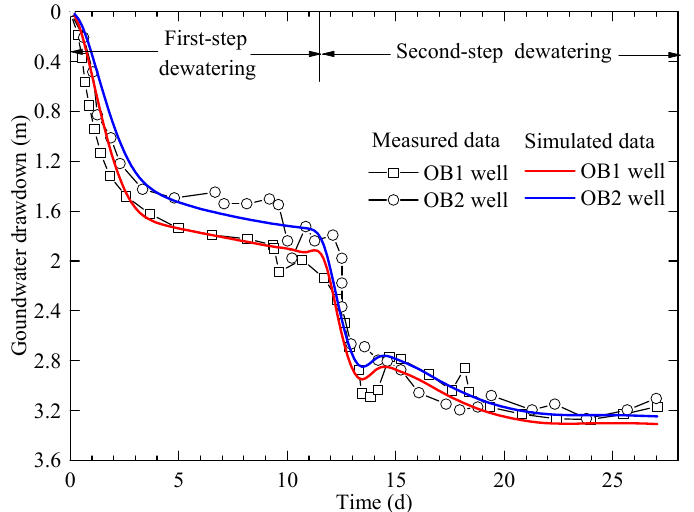
Figure 7. Comparison of measured and simulated groundwater level of observation wells in pumping test.